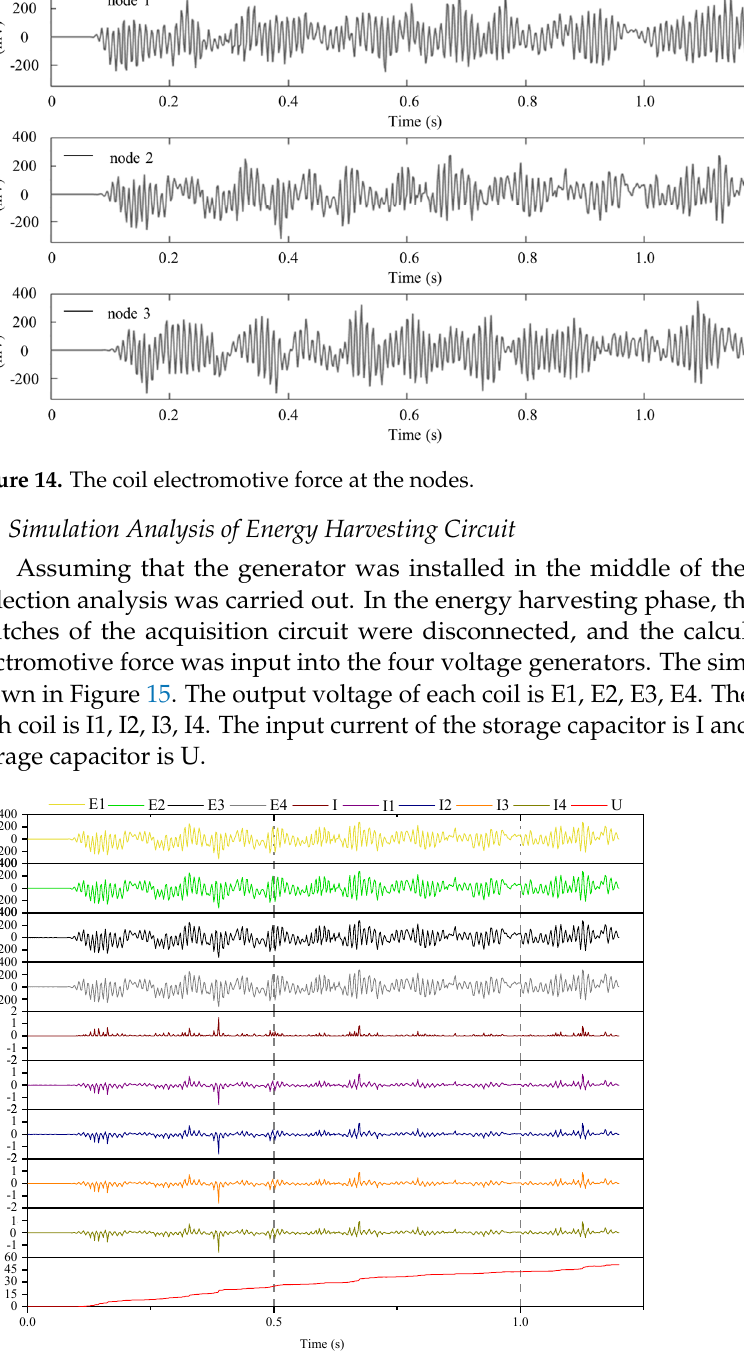
Figure 14. The coil electromotive force at the nodes.